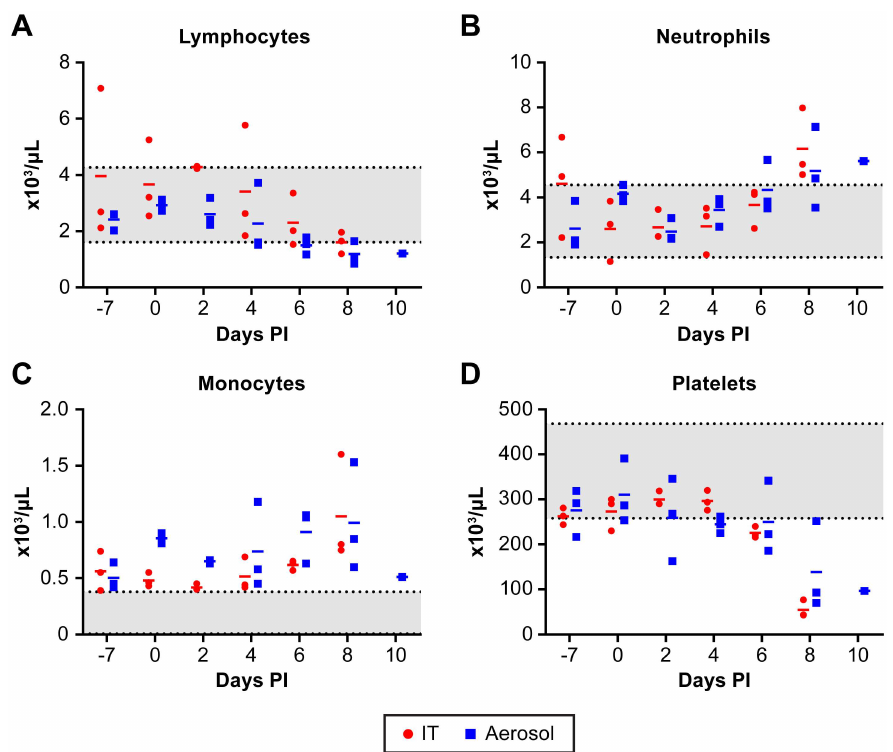
Fig 2. CBC on NiV infected AGMs. Temporal analysisof lymphocytes (A), neutrophils(B), monocytes (C) and platelets (D) demonstrating lymphopenia, neutrophiliaand monocytosis developingover the course of disease.The rapid drop in platelet count occurs in the terminalphase of disease.IT inoculatedanimalsare indicatedby ( ● ) and aerosol inoculated animalsby ( ■ ). The mean for the group is indicatedby a dash (-). The shadedarea indicatesthe normal range for the specifiedvalue